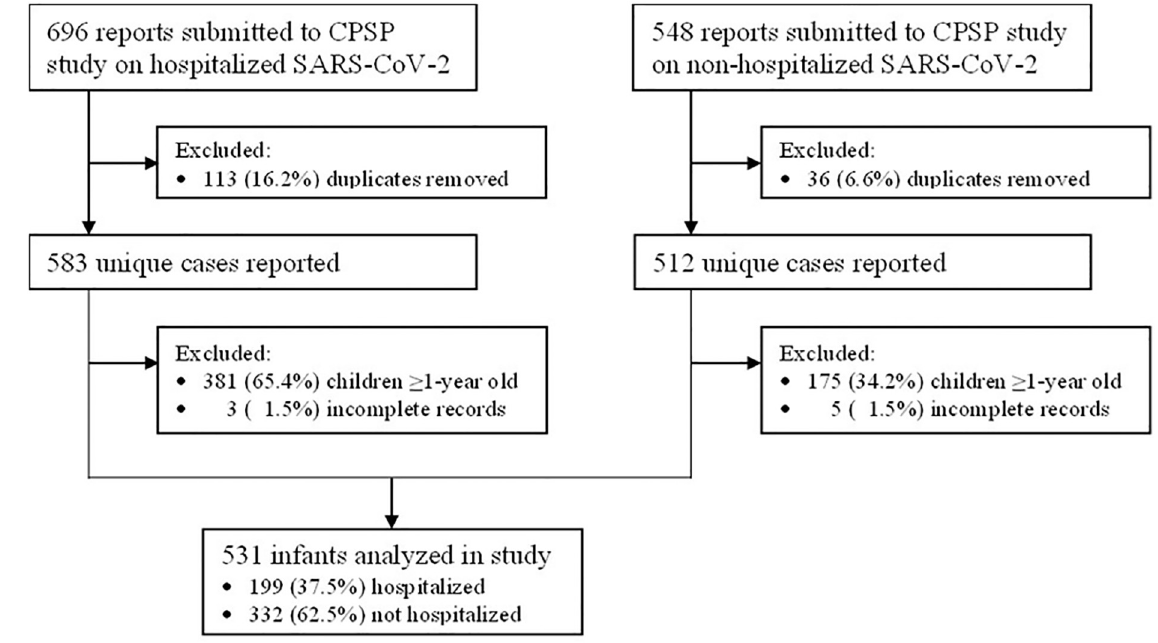
Fig 1. Flow chart of cases reported to the CPSP COVID-19 study until May 31, 2021.